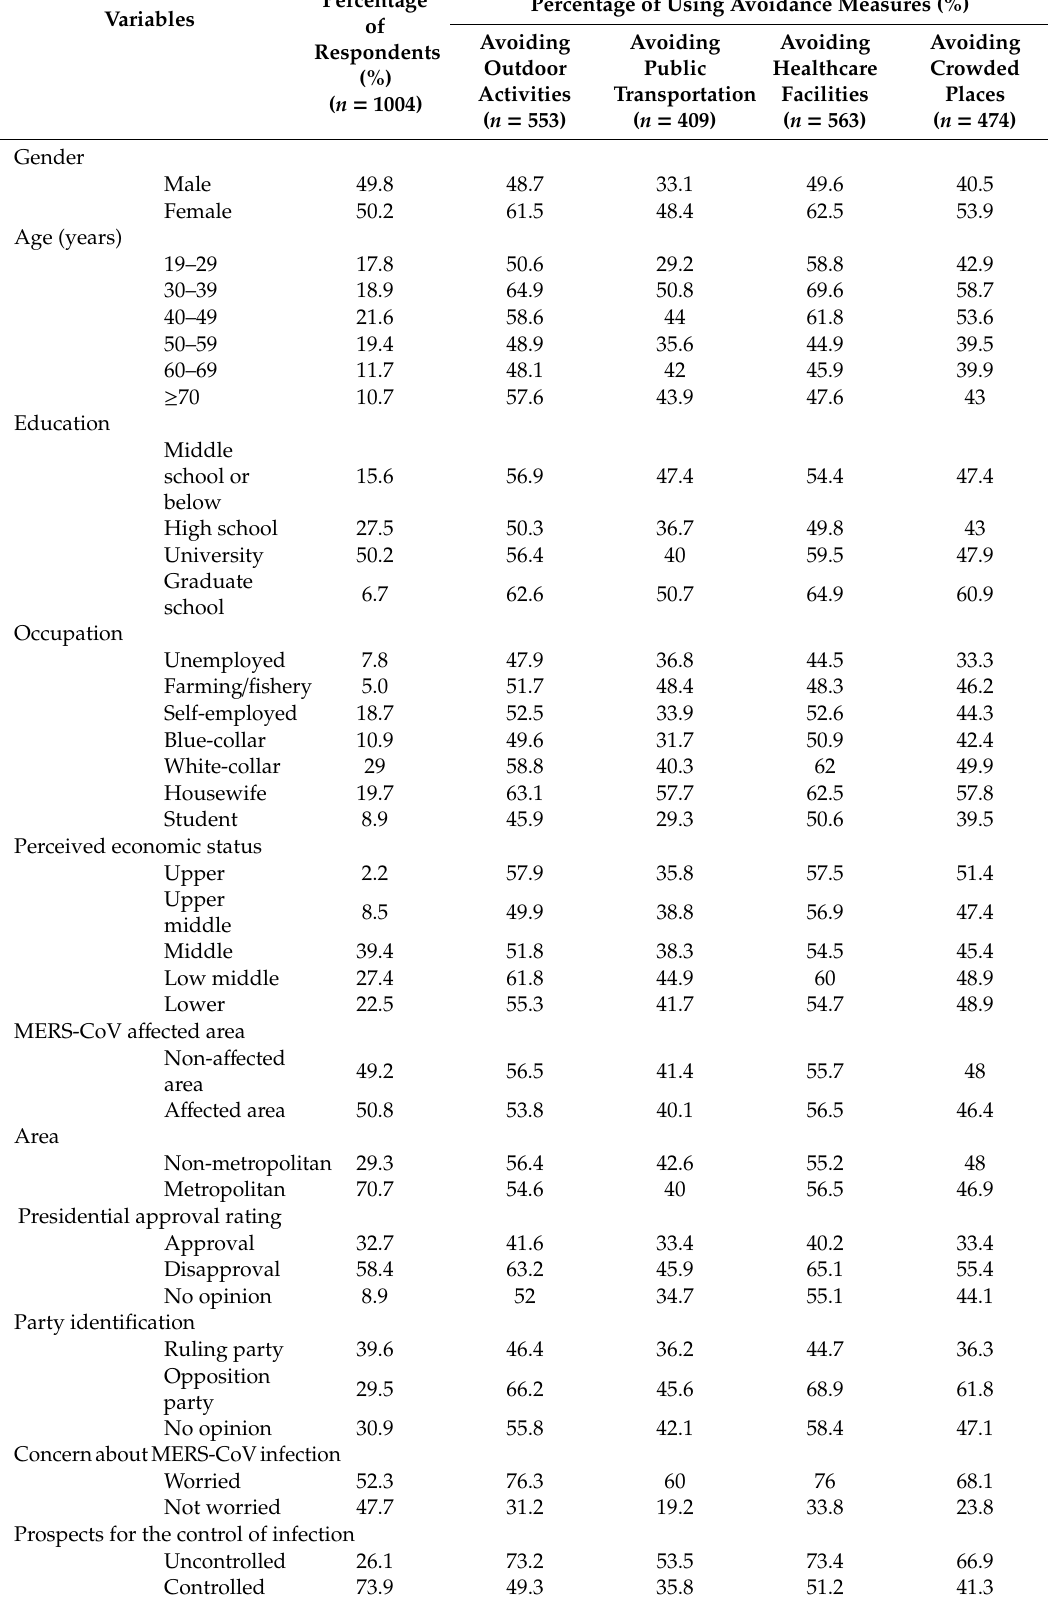
Table 2. Characteristics of the respondents and use of avoidance measures (Survey